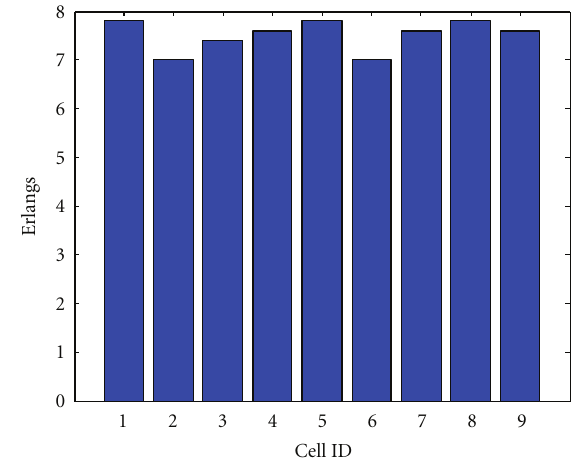
Figure 8: Final load handled by the femtocells (no. of FBSs = 9).